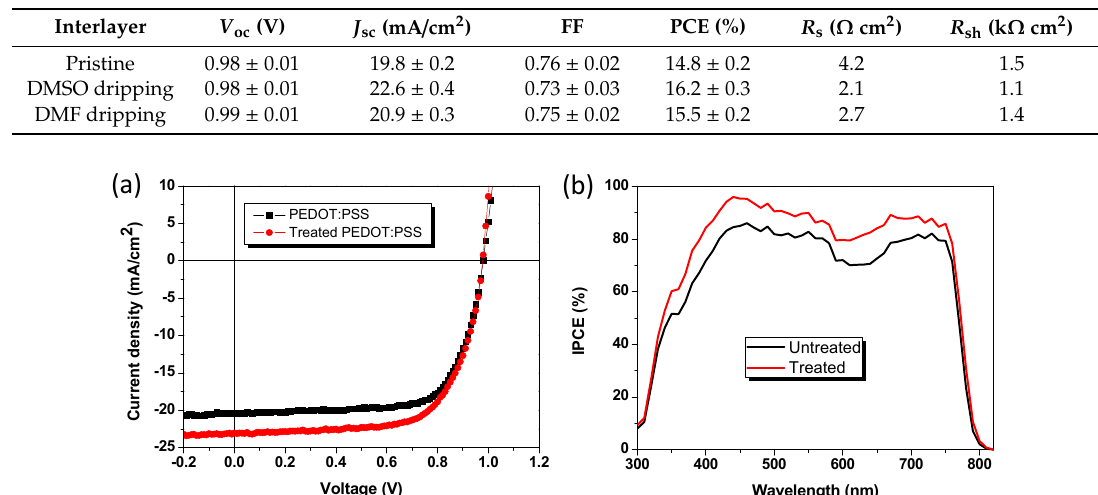
Figure 8. Hysteresis characteristics of perovskite solar cells based on pristine and DMSO solvent washing treated PEDOT:PSS layers.